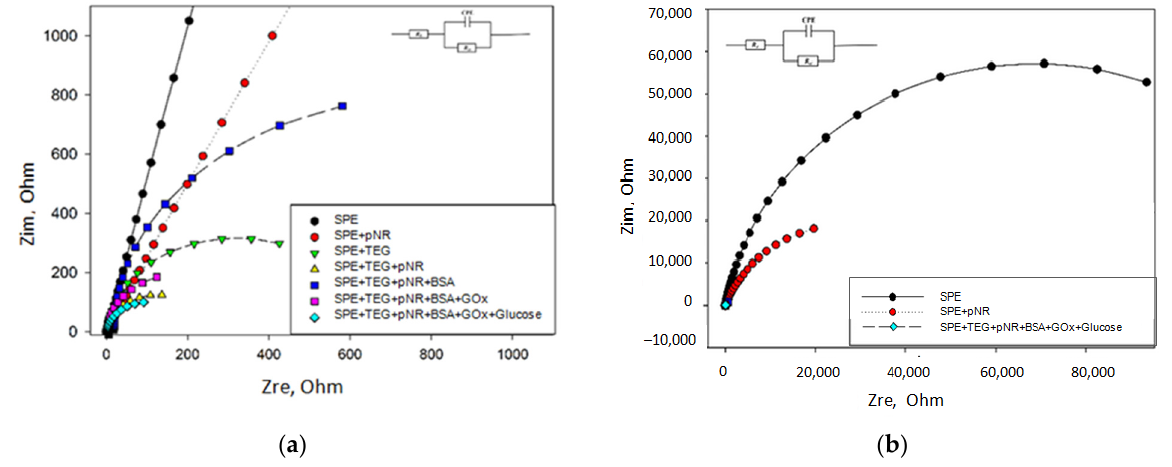
Figure 6. Nyquist plots from EIS results for various composites ( a ). Increased high frequency region for Nyquist diagrams ( b ).